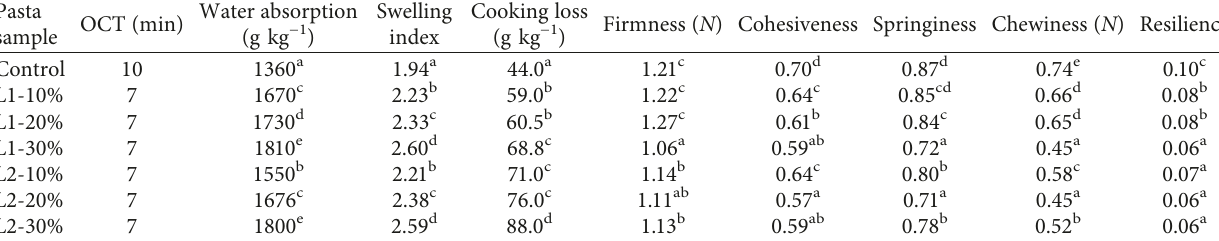
Table 4: Cooking properties of wheat pasta and wheat-kañawa pasta. Pasta Water absorption OCT (min) sample (g kg − 1